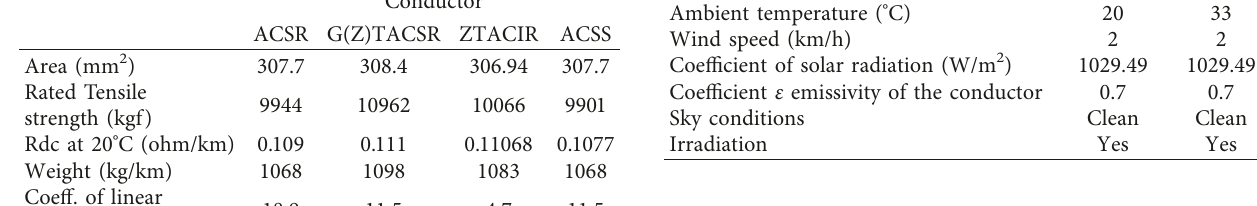
Table 3: East Sicily HTLS conductors